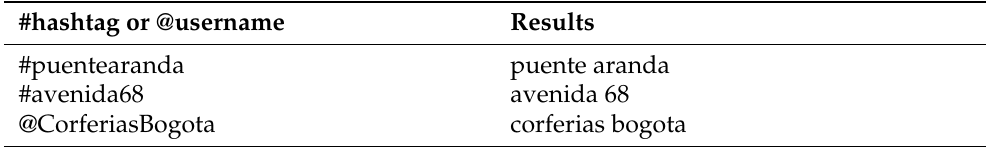
Table 3. Results of the word segmenter with tweets in